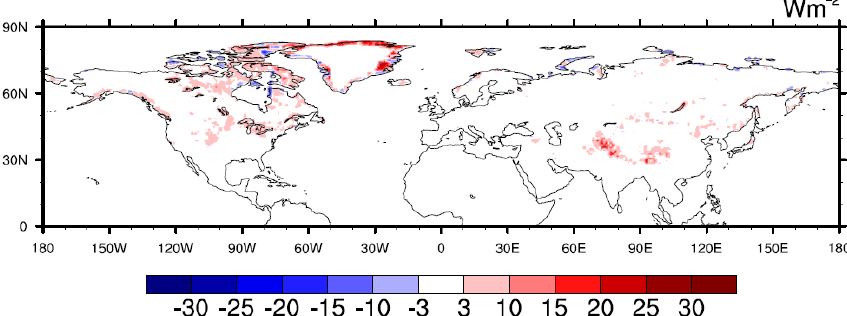
Figure 9. Difference of 2001–2008 mean LCrRE between the current study and Flanner et al. (2011) using CAM3 kernels. Areas of red indicate a stronger (more negative) LCrRE determined by Flanner et al. (2011) than determined here.